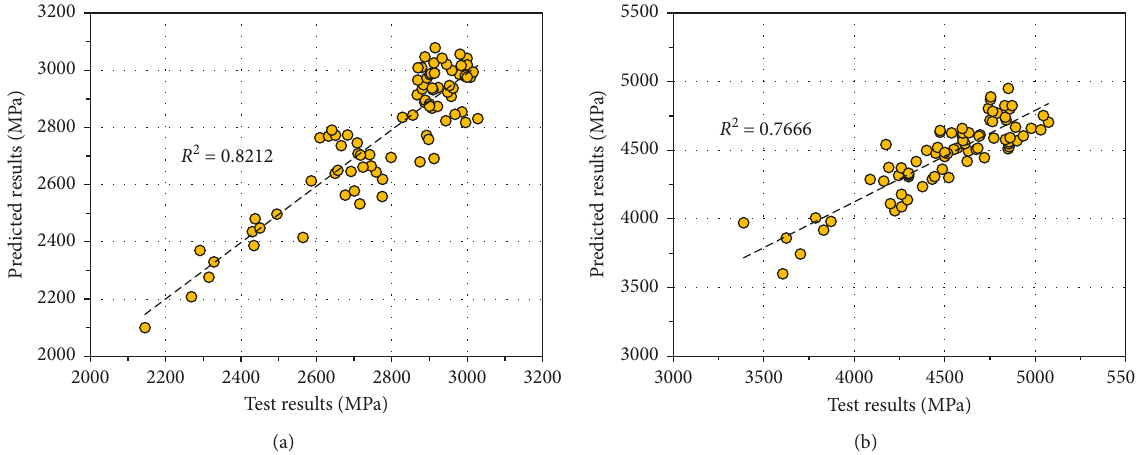
Figure 10: Correlation analysis of the proposed formula for postyielding fatigue strain of the rebar: (a) correlation between experimental and predicted rebar strains for RC-SR; (b) correlation between experimental and predicted rebar strains for RC-HR.